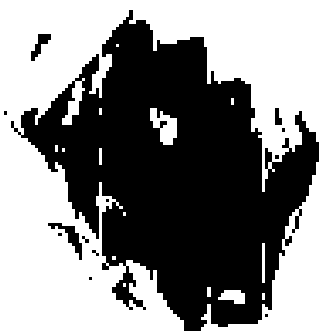
Figure 10. Binary image of effective points.